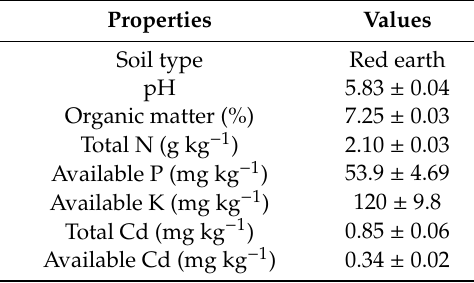
Table 1. Basic physio-chemical properties of the soil used for the experiment.